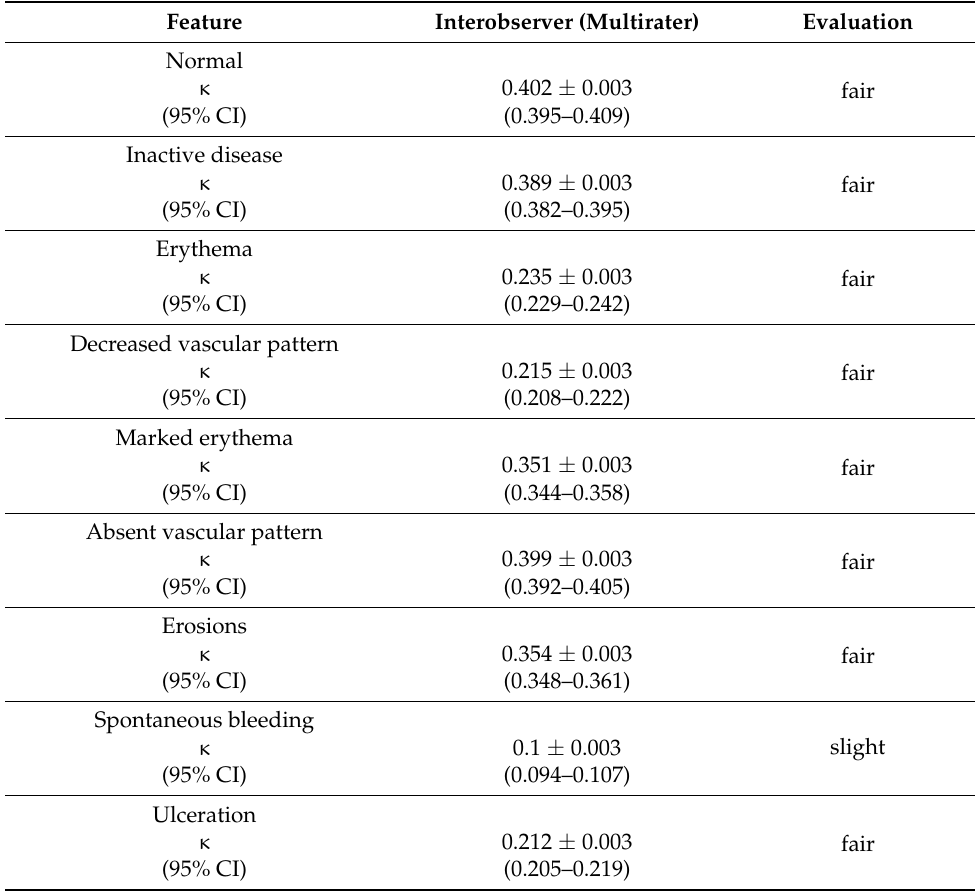
Table 1. Interobserver reliability of MES parameters for all 42